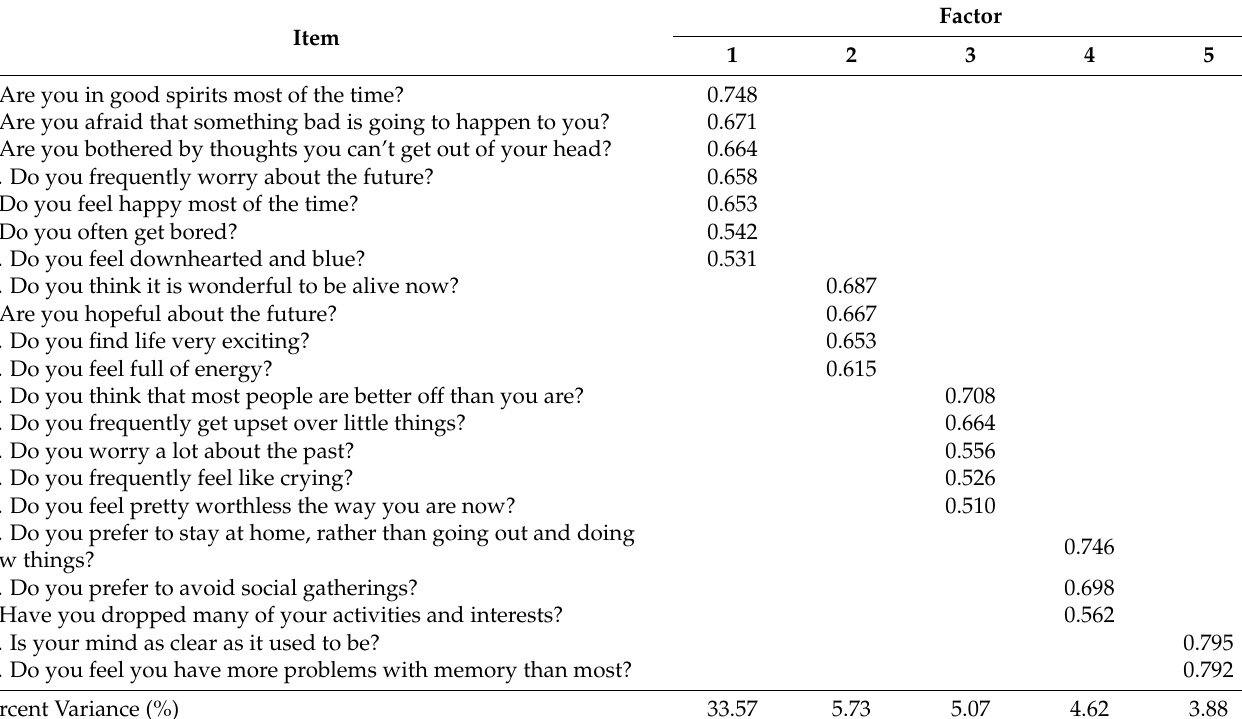
Table 7. Factor analysis of the GDS-30